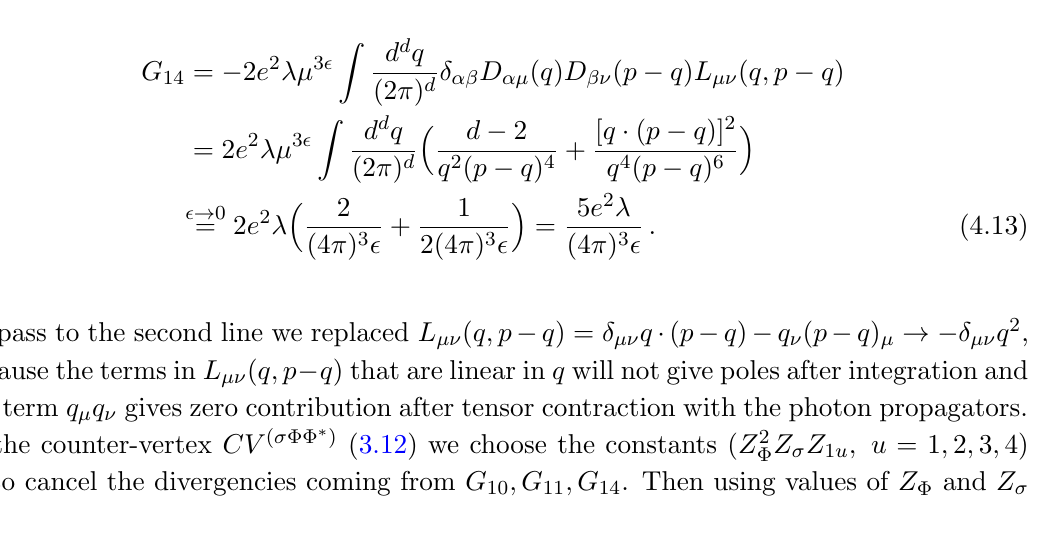
using the transversality condition that the integral vanishes. The graph G